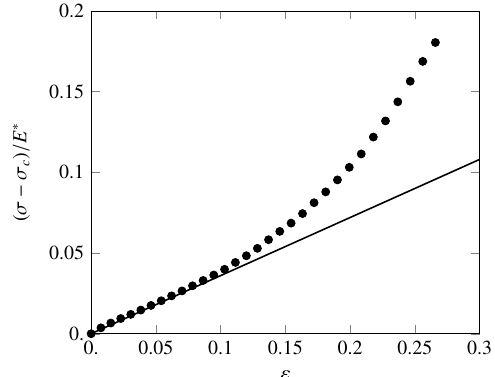
 c normalized by